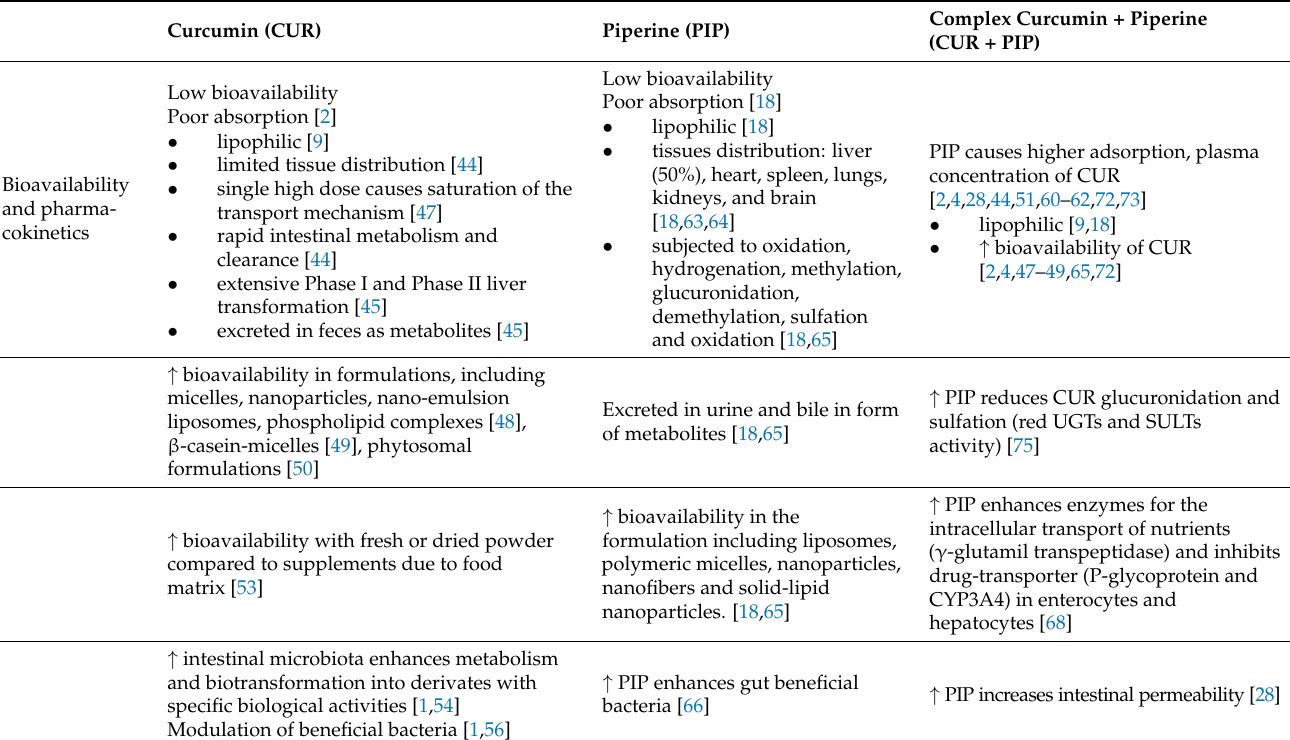
Table A1. Summary of bioavailability, adverse effects, plasma peak concentrations and safety of curcumin and piperine as single agents and in combination in